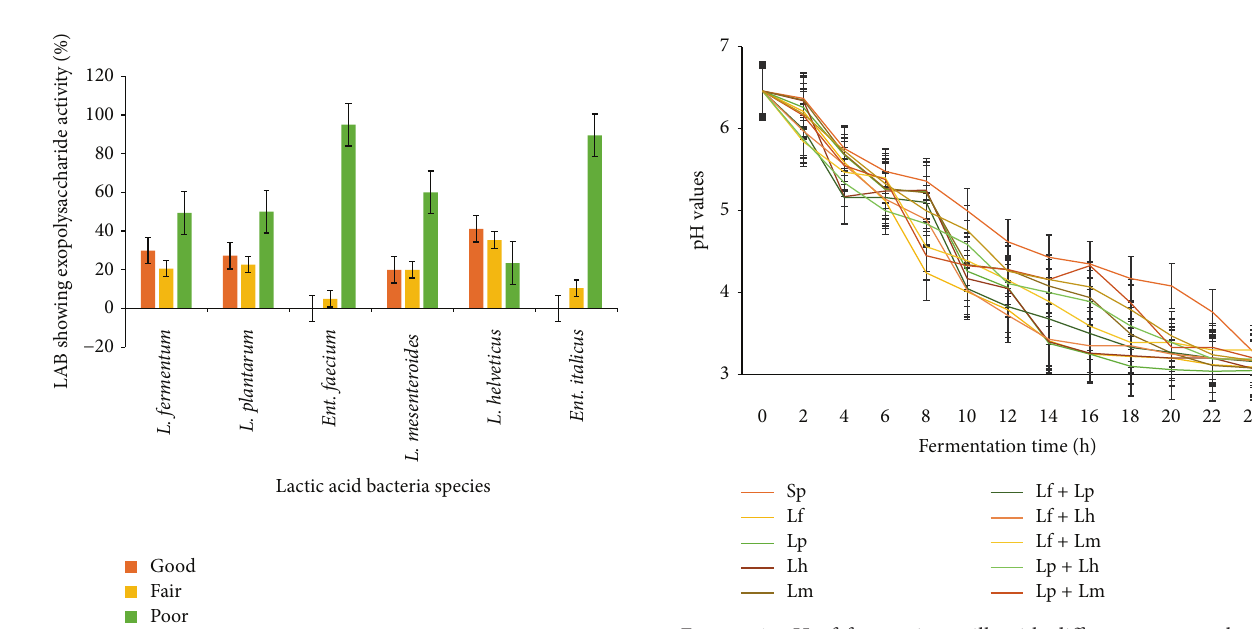
Figure 3: Exopolysaccharides activities of predominant LAB iso- lated from Nunu . Good => 100–150 𝜇 g/mL, fair => 50–100 𝜇 g/mL, and poor = 0–50 𝜇 g/mL.